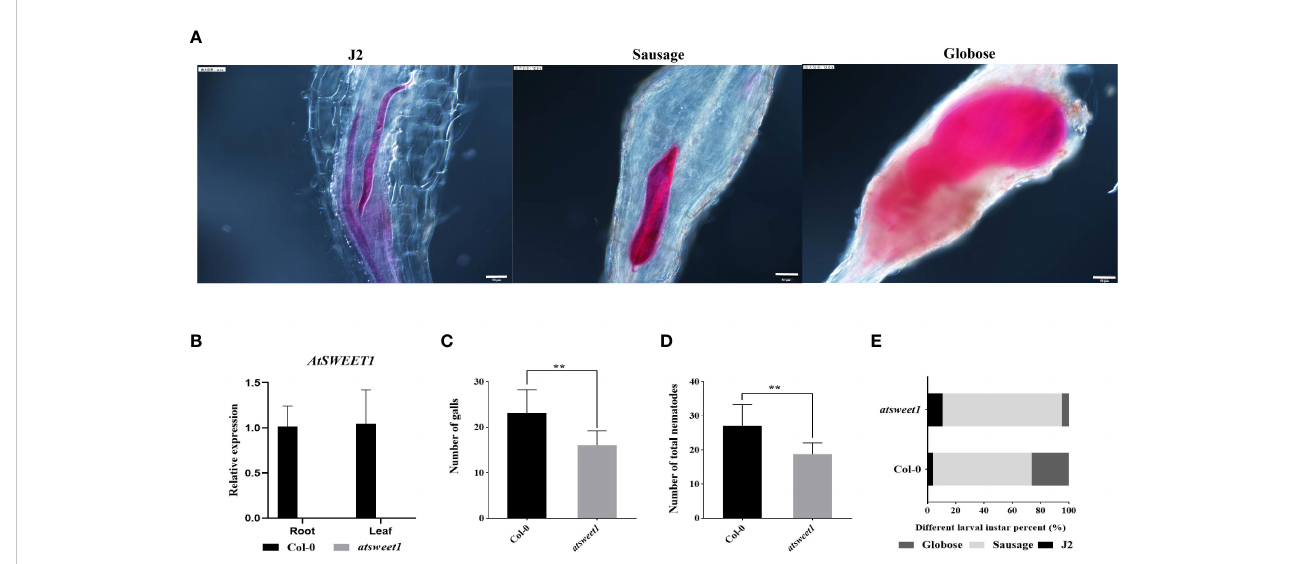
FIGURE 3 Response of A. thaliana atsweet1 mutants and wild-type Col-0 plants to M. incognita infection. (A) The developmental morphology of nematodes at the J2 stage, Sausage stage, and Globose stage. (B) The relative expression levels of the AtSWEET1 gene in atsweet1 mutant plants were analyzed through quantitative reverse transcription PCR. Using col-0 plants as control, fi ve biological replicates and three technical repeats were performed per sample. The Actin 8 gene was used as an internal control. (C) The number of galls in the root of Arabidopsis inoculated with M. incognita at 18 dpi. The number of galls is signi fi cantly reduced in the atsweet1 mutant plants than in the Col-0 plants; (D) It shows the total number of nematode-infected Arabidopsis . (E) Percentage of nematodes corresponding to different developmental stages (J2 stage; Sausage stage; Globose stage) in the atsweet1 mutants and wild-type Col-0 at 18 dpi (n = 15). Data are presented as mean ± SD, and p-values were analyzed using student ’ s t-test (p**<0.01). Scale bars=50 m m.